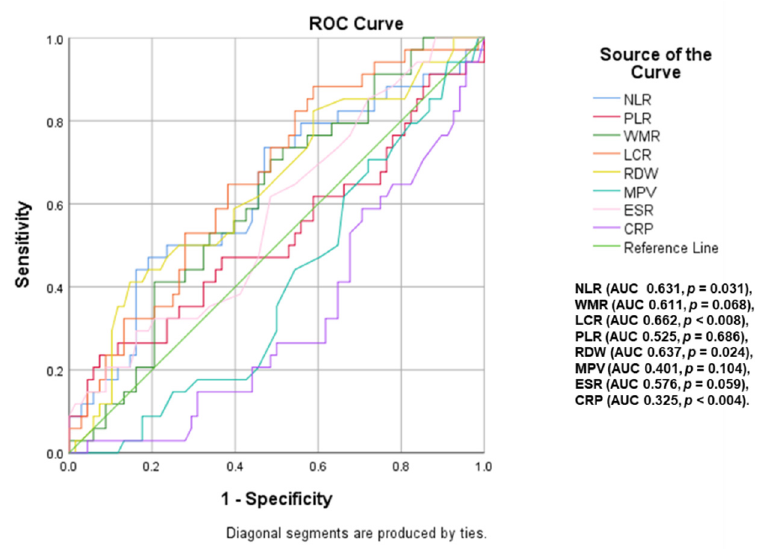
Figure 4. Impact of inflammatory parameters in predicting severe OSA (NLR: neutrophil–lymphocyte ratio; WMR: white blood cell count-to-mean platelet volume ratio; LCR: lymphocyte-to-CRP ratio; ESR: erythrocyte sedimentation rate; CRP: C-reactive protein; PLR: platelet-to-lymphocyte ratio; RDW: red cell distribution width; MPV: mean platelet volume).